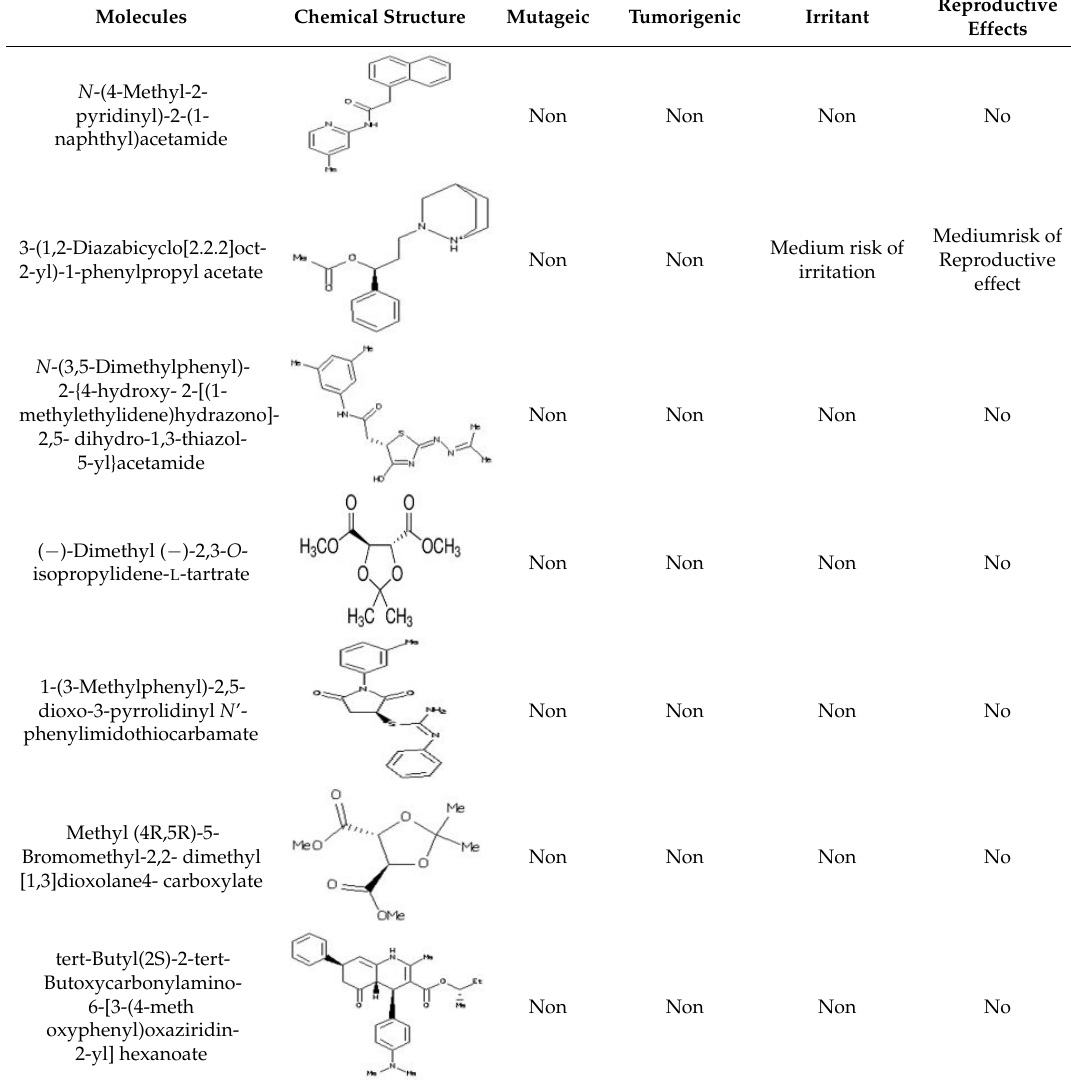
Table 2. Toxicity study of the top seven ligands produced by Dock Blaster after HTS against a drug like subset of ZINC database. Due to the toxicity effect, the removed molecules are in bold.